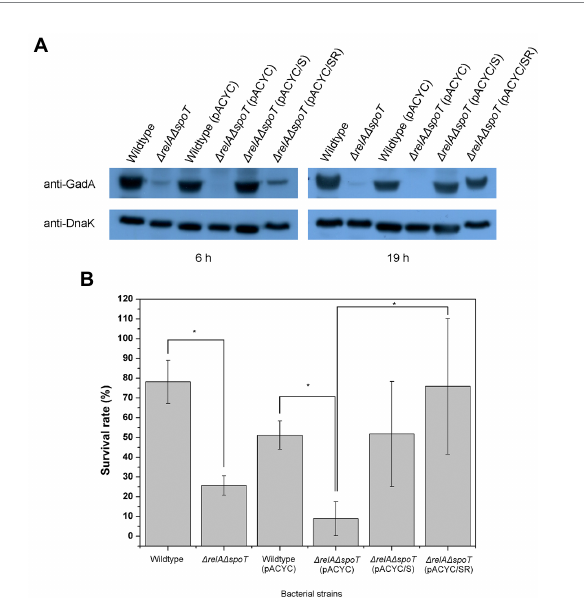
FIGURE 4 Reduced glutamate decarboxylase (GAD) expression and acid resistance in Δ relA Δ spoT EPEC. (A) Expression of GAD protein. Wildtype and mutant strains grown in Luria-Bertani (LB) at 37 ° C for 18 h were diluted with pre-warmed LB and further incubated at 37 ° C for 6 or 19 h. Equal amounts (200 μ g) of proteins were obtained from each strain and analyzed by western blotting to detect GadA. DnaK was used as an internal control. Wildtype, E2348/69 strain; Δ relA Δ spoT , E2348/69 Δ relA Δ spoT mutant; wildtype (pACYC), E2348/69 carrying pACYC184; Δ relA Δ spoT (pACYC), E2348/69 Δ relA Δ spoT carrying pACYC184; Δ relA Δ spoT (pACYC/S), E2348/69 Δ relA Δ spoT carrying pACYC/S; Δ relA Δ spoT (pACYC/SR), E2348/69 Δ relA Δ spoT carrying pACYC/SR. (B) Survival rate of wildtype and mutant strains in E minimal glucose medium (pH 3.0; 1.5 mM glutamate) after incubating at 37 ° C with shaking for 2 h. Bacterial survival rate was determined by comparing colony forming units before and after acid shock. Values are presented as mean ± standard error of the mean ( n = 3). Statistical significance was obtained by Student’s t -test (* p <